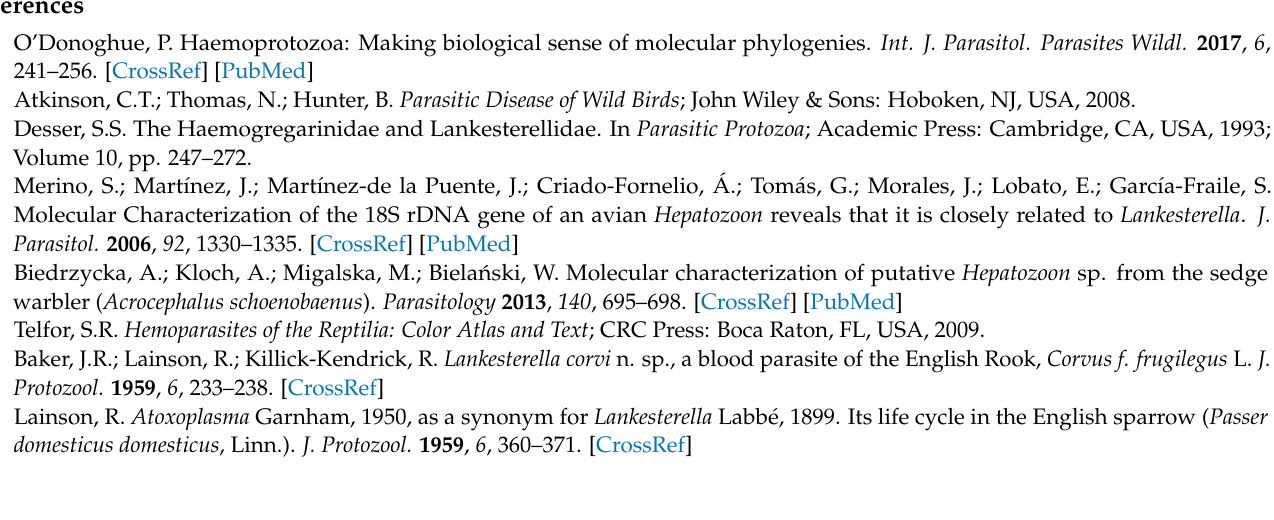
Table S2: GenBank accession numbers of partial 18S rRNA gene sequences and parasite species